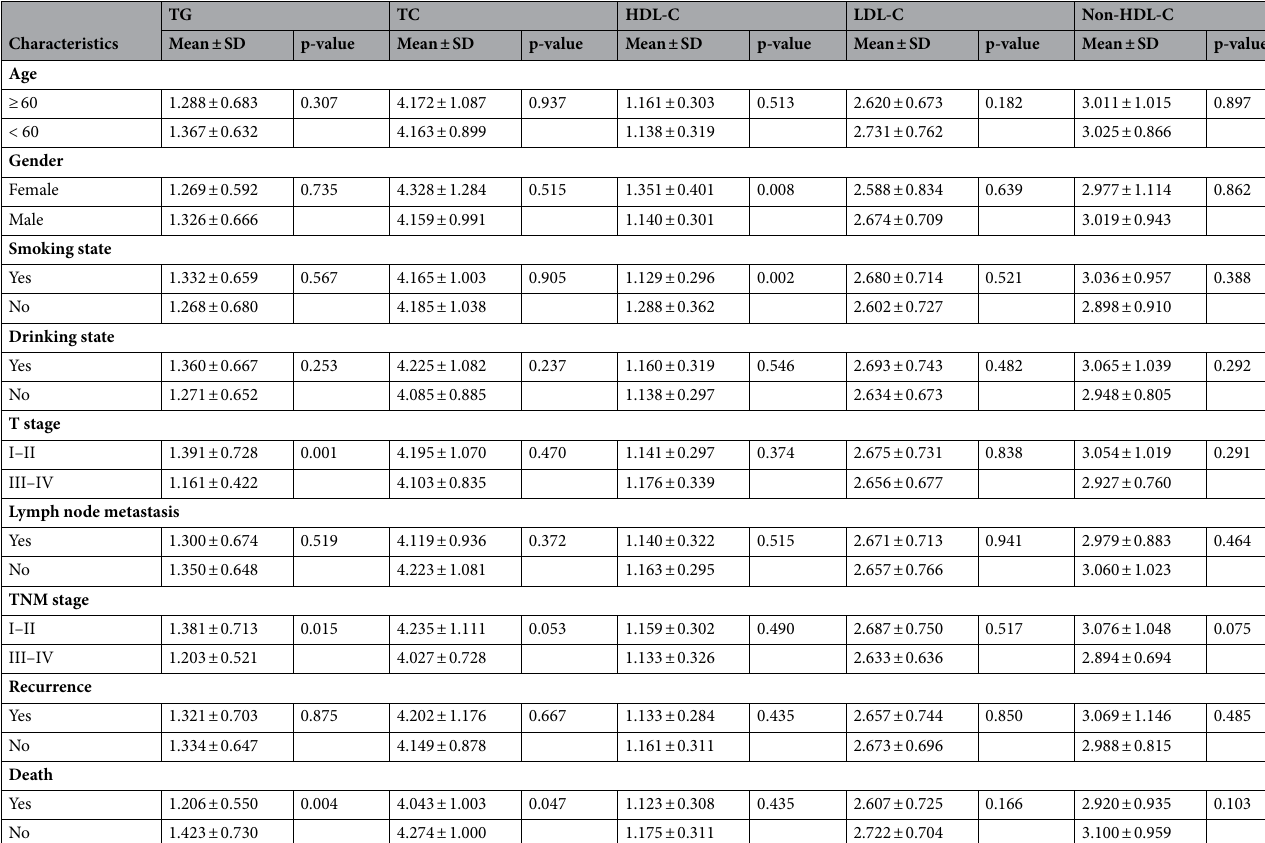
Table 2. Clinical characteristics of 300 patients with squamous cell carcinoma of lung based on TG/TC/ HDL-C/LDL-C expression